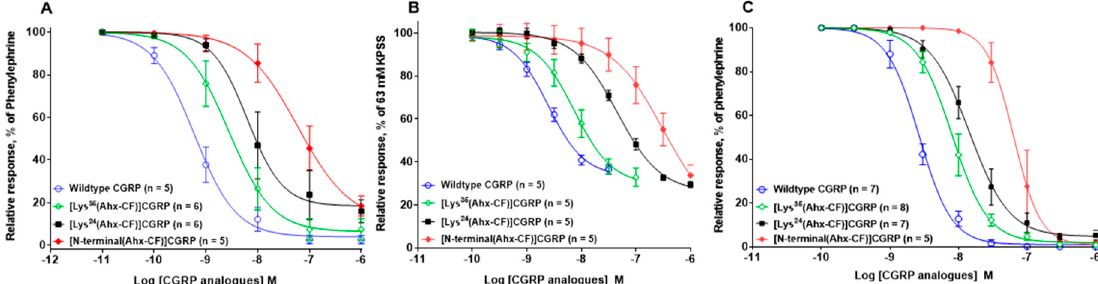
Figure 3. Cumulative concentration–response curves (10 pM–1 µM) for wild-type CGRP and fluorescently tagged analogues in isolated ( A ) mouse mesenteric arteries with an average lumen diameter of 212 ± 14 µm ( n = 22), ( B ) rat mesenteric arteries with an average lumen diameter of 284 ± 8 µm ( n = 20), and ( C ) human subcutaneous arteries with an average lumen diameter of 654 ± 39 µm ( n = 27). Data points represent mean values and vertical bars indicate ± SEM (Standard error of mean), where this value exceeds the size of symbol ( n = number of animals or number of human subcutaneous arterial ring segments). Relative responses are given as fraction (stated as percentages) of the initial vessel contractile response to either 10 µM phenylephrine or KPSS buffer containing 63 mM K + just before they were challenged with wild-type h- α -CGRP and its fluorescently tagged analogues.